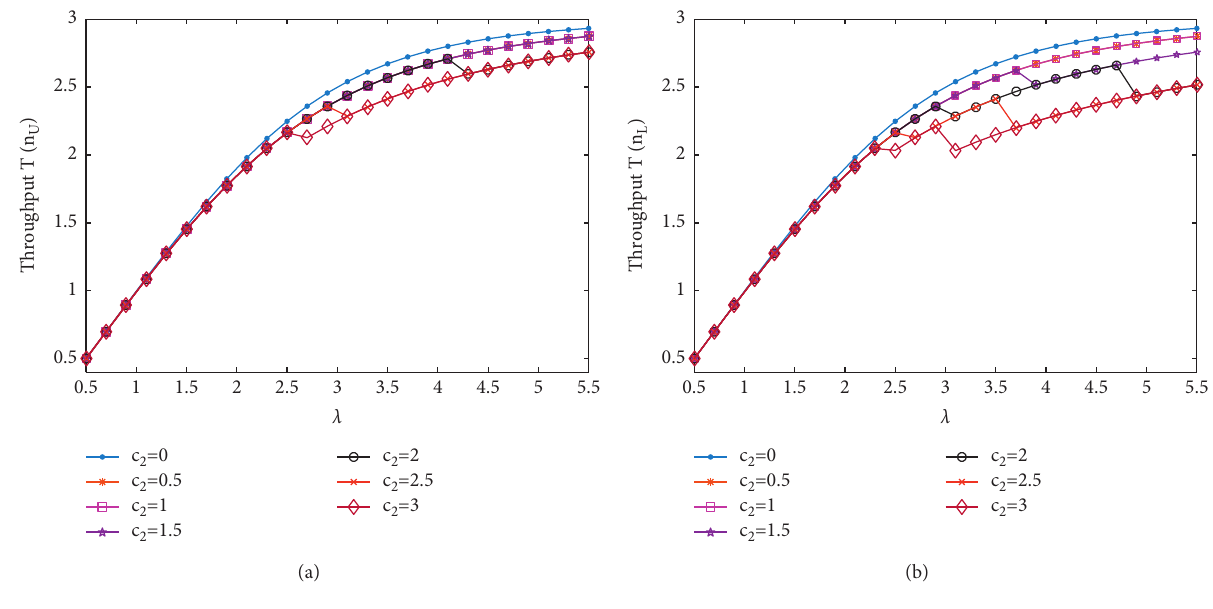
Figure 5: The throughputs T ( n